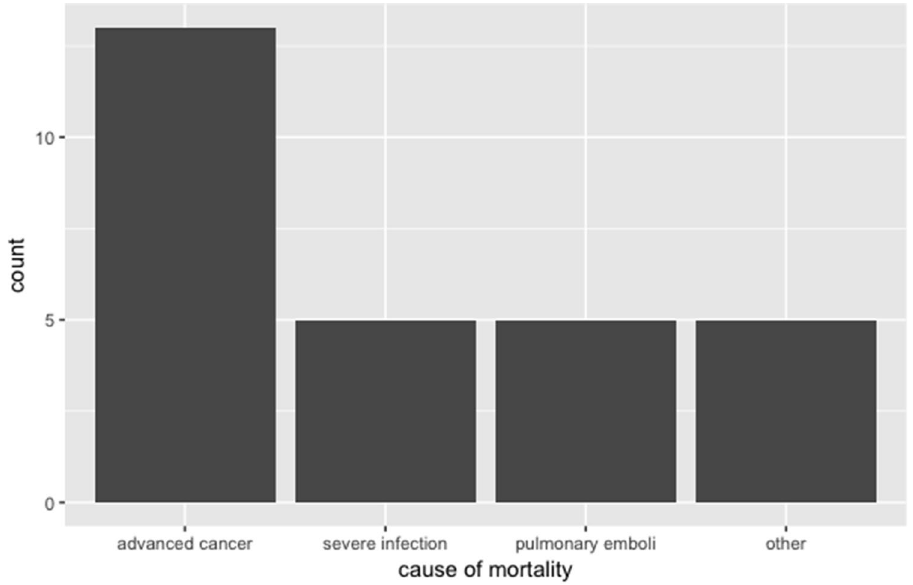
Figure 3. Cause of mortality. Other: stroke, acute myocardial infarction, COPD, ESRD with hyperkalemia.